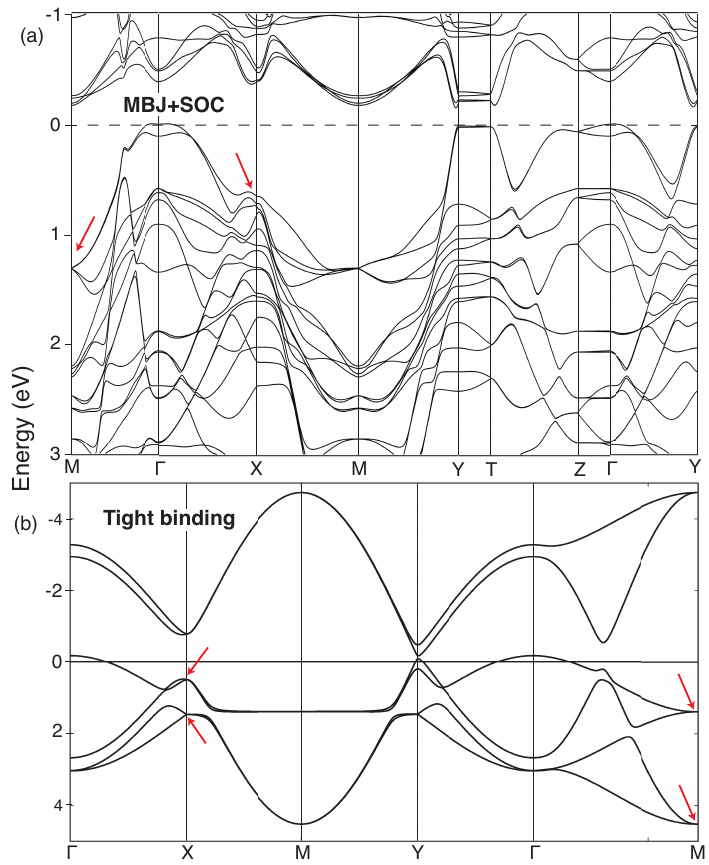
from DFT and tight binding calculations (a) Figure 5: Electronic structure of SrMnSb 2 Calculated band structure of SrMnSb using a MBJ exchange potential within the DFT for- 2 malism. Intrinsic spin-orbit coupling and magnetism are also included; (b) calculated band structure from a tight binding model for the p orbitals of Sb atoms arranged in a buckled x , y , z square lattice as is the case in the SrMnSb structure. In both cases, the red arrows point to 2 band crossings at X and M that are protected by non-symmorphic